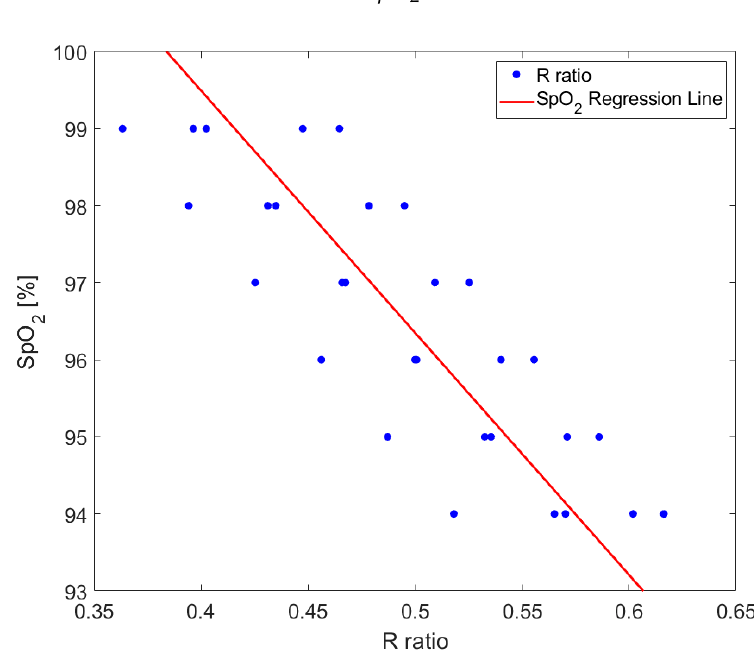
Figure 3. Scatter plot of the 25 data pairs of R to SpO 2 used for calibration (blue dots) and the computed SpO 2 regression line (red line).